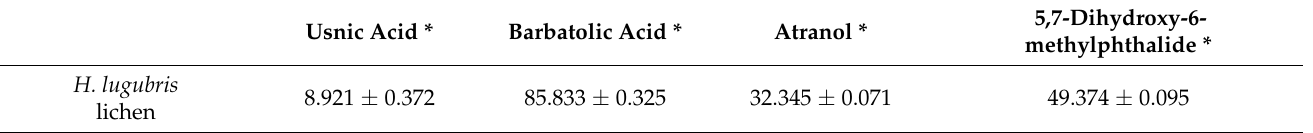
Table 2. Quantitation of main compounds in of H. lugubris ethanolic extract (mg/g dried